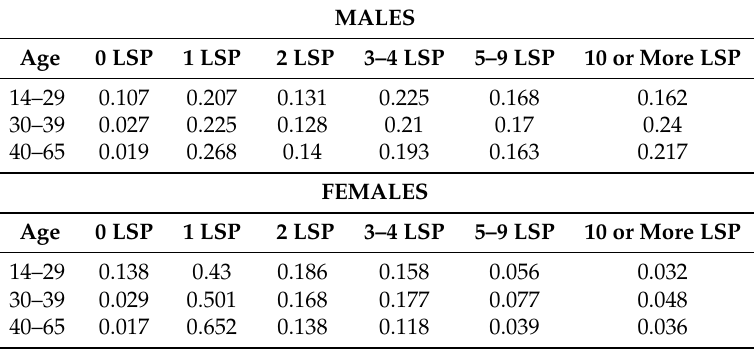
Table 1. Proportion of males and females per number of life sexual partners LSP per age